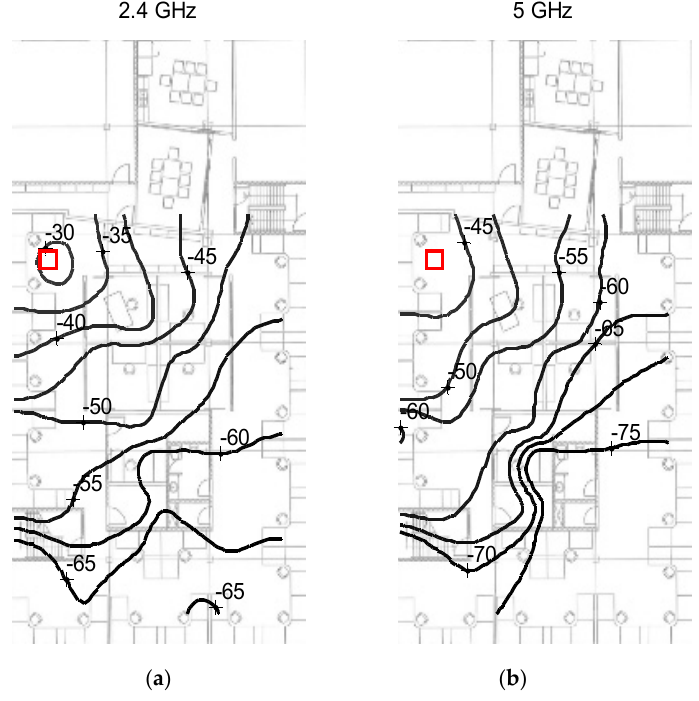
Figure 14. Office radio map (RM) for 2.4 and 5 GHz for Wi-Fi channel, red square is location of AP, numbers are given in dBm ( a ) 2.4 GHz Wi-Fi data; ( b ) 5 GHz Wi-Fi data.